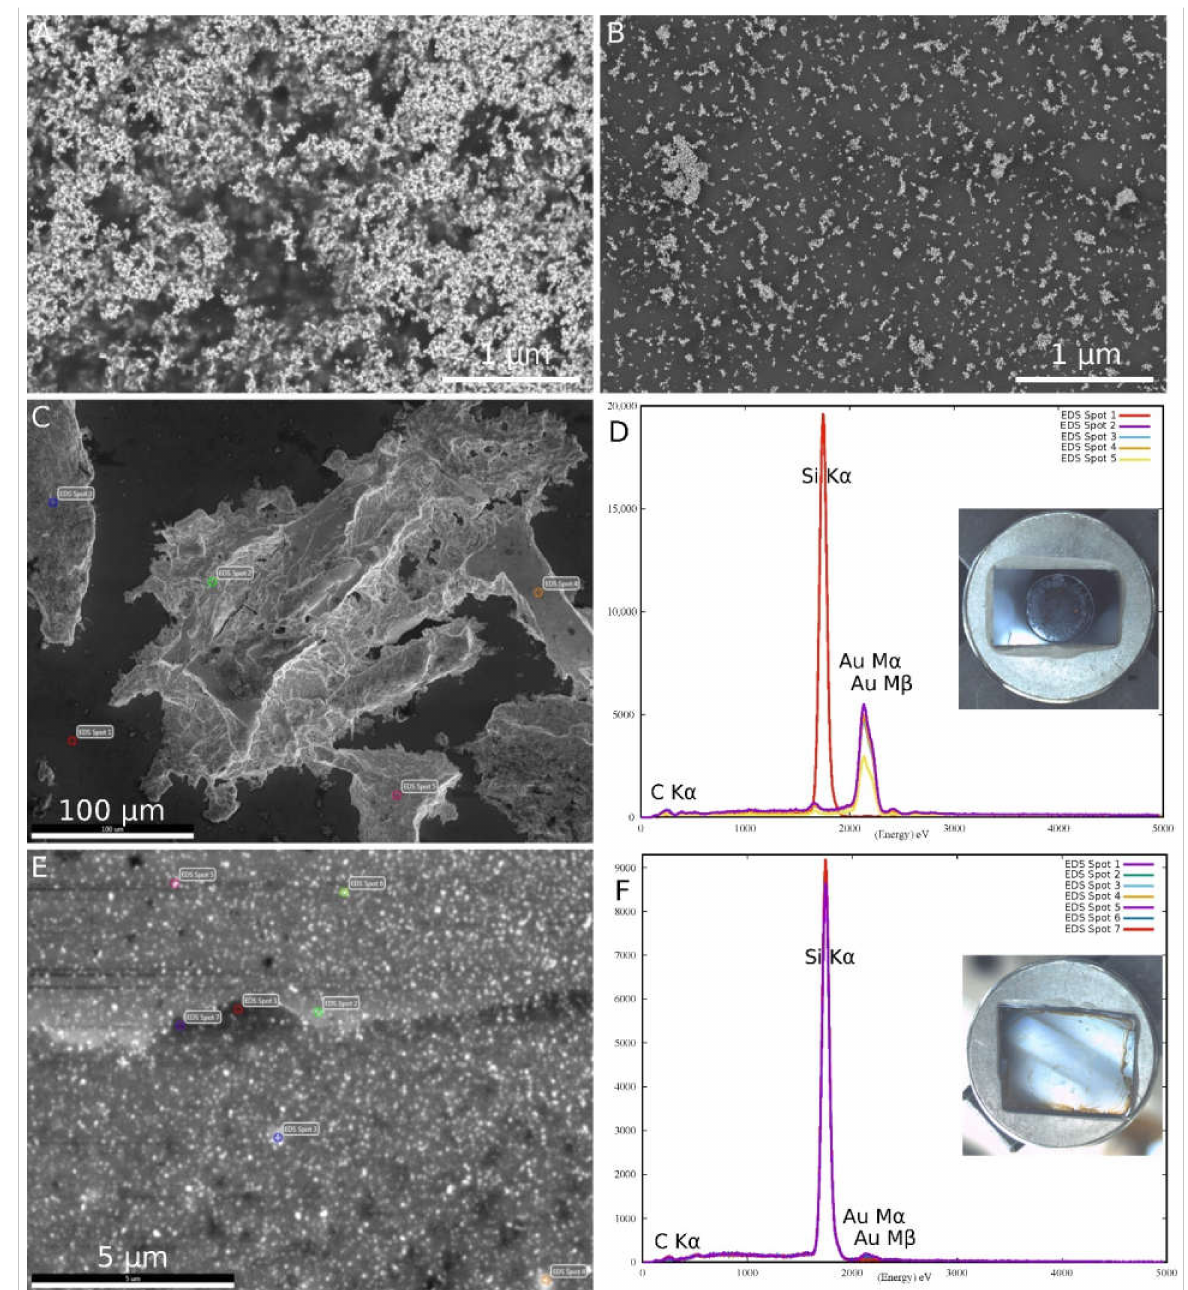
Figure 6. SEM and EDS images of different samples. ( A ) SEM results of a washed pH 2 sample of glow-discharge-activated silicon wafer. ( B ) SEM results of a washed sample at pH 10 from glow-discharge-activated silicon wafer. ( C , D ) EDS analysis of a washed sample on a non-activated silicon wafer support. Drying the sample on a hydrophobic surface resulted in the formation of large aggregates of AuNPs at the edge of the dried sample. The individual spot positions marked in ( C ) and the corresponding spectra can be seen in ( D ). ( E , F ) EDS analysis of a washed sample at pH 10 on an activated silicon wafer support. The aggregation of AuNPs at the edge of the sample was minimized; however, the Au signal from the individual AuNPs was weak, while the intensity of the Si K α peak from the silicon wafer support was predominant. The inserts in ( D , F ) show the effect of non-activated ( D ) and activated ( F ) silicon wafer supports on the final SEM sample formation after air-drying. Scale bars: ( A , B ) = 1 µ m; ( C ) = 100 µ m; ( E ) = 5 µ